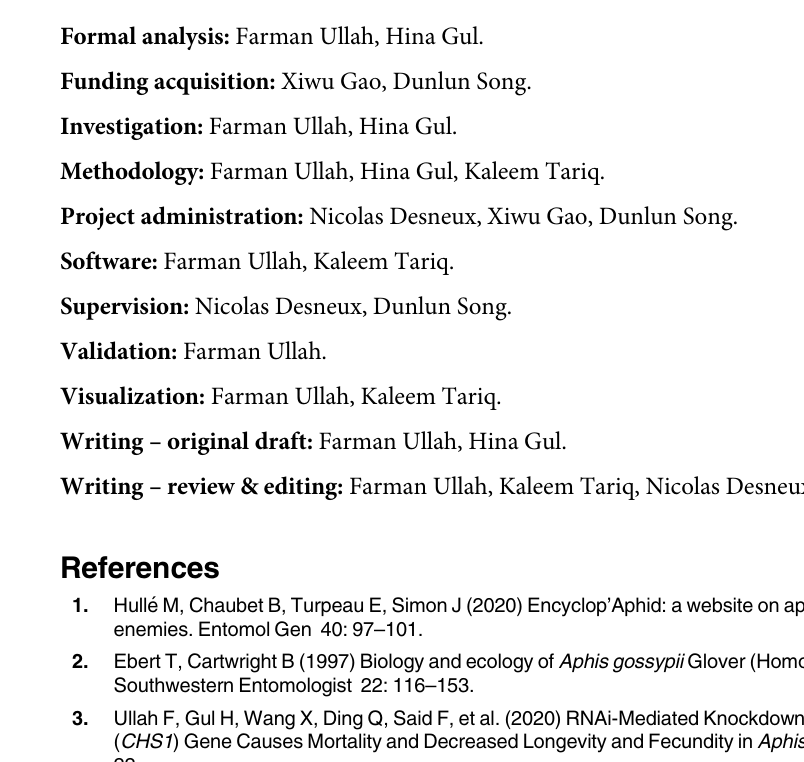
S1 Table. Life table of susceptible strain (CT-S) of A . gossypii . (XLSX) S2 Table. Life table of clothianidin-resistant strain (CT-R) of A . gossypii .